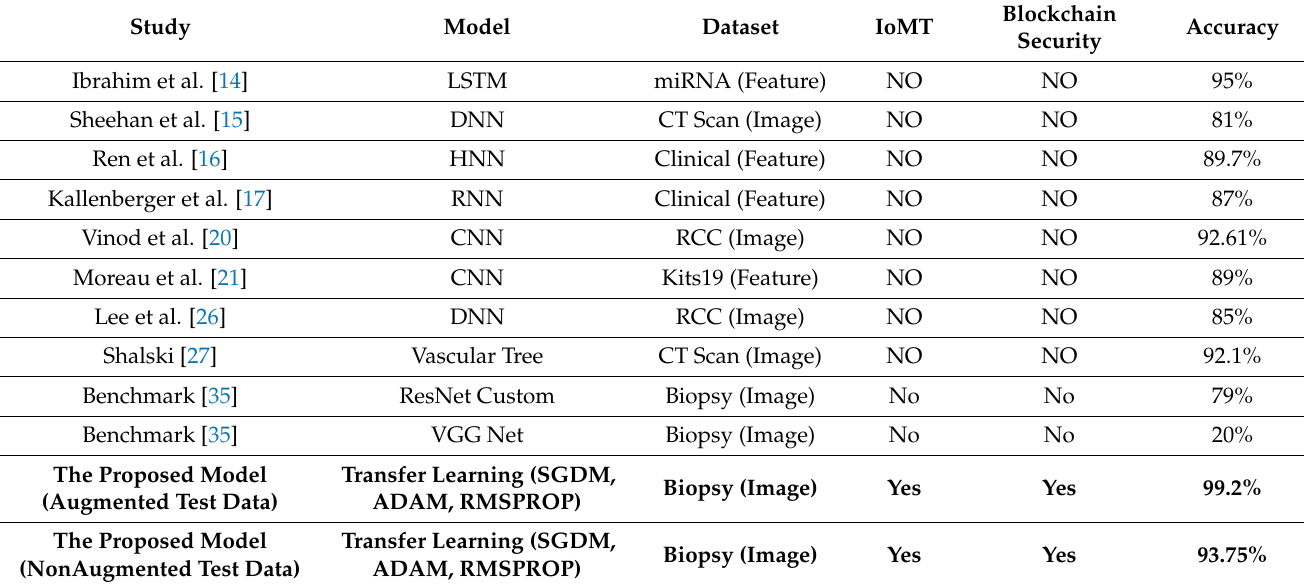
Table 11. Comparative analysis of the proposed framework with previous